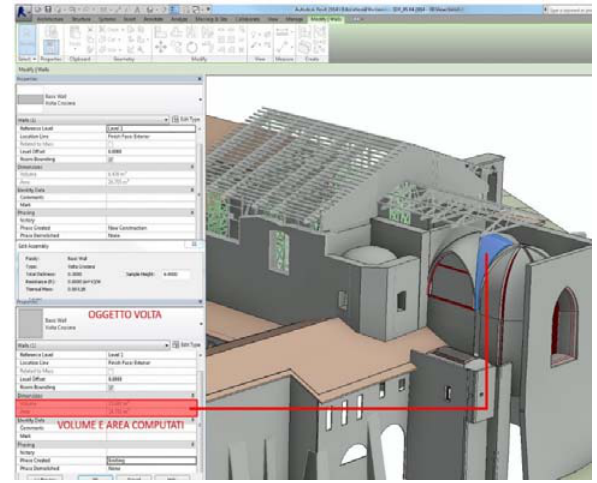
Figure 2. HBIM of the Basilica, divided in structural elements: wall, floor, roof, pillar, vault, door, window, etc.